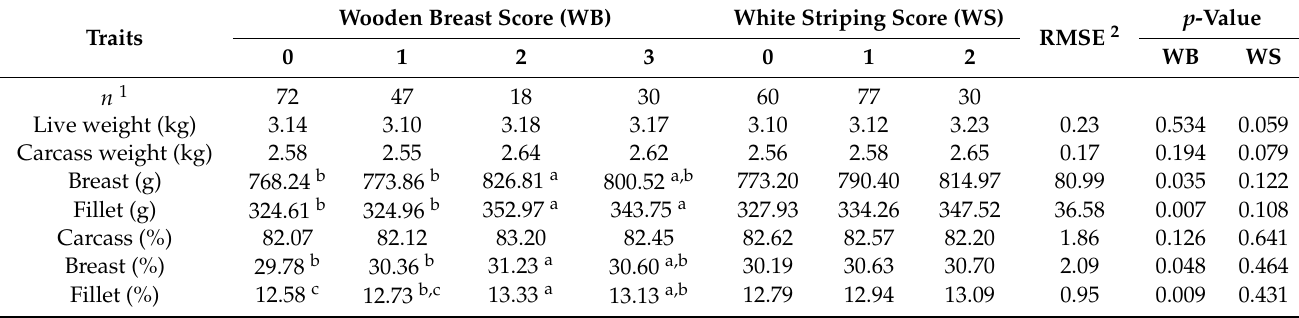
Table 7. Carcass composition with different degree of